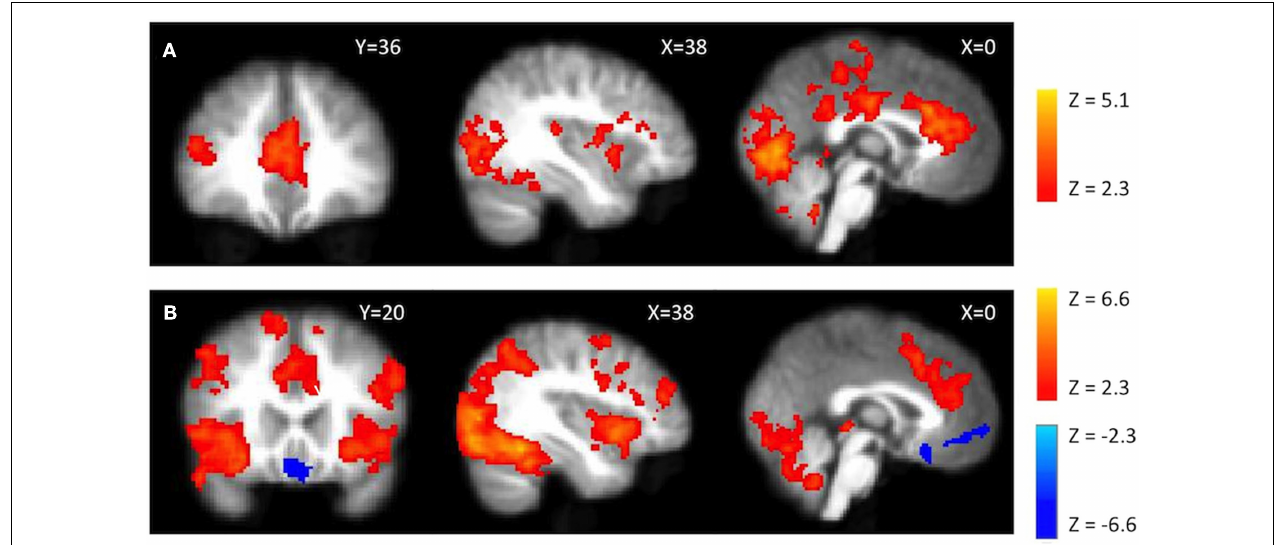
FIGURE 5 | fMRI activations during explosions. (A) Parametrically modulated activity (by number of pumps) during explosion events. (B) Average activity during explosion events. Red scale presents positive activations and blue scale presents the negative of the contrast.